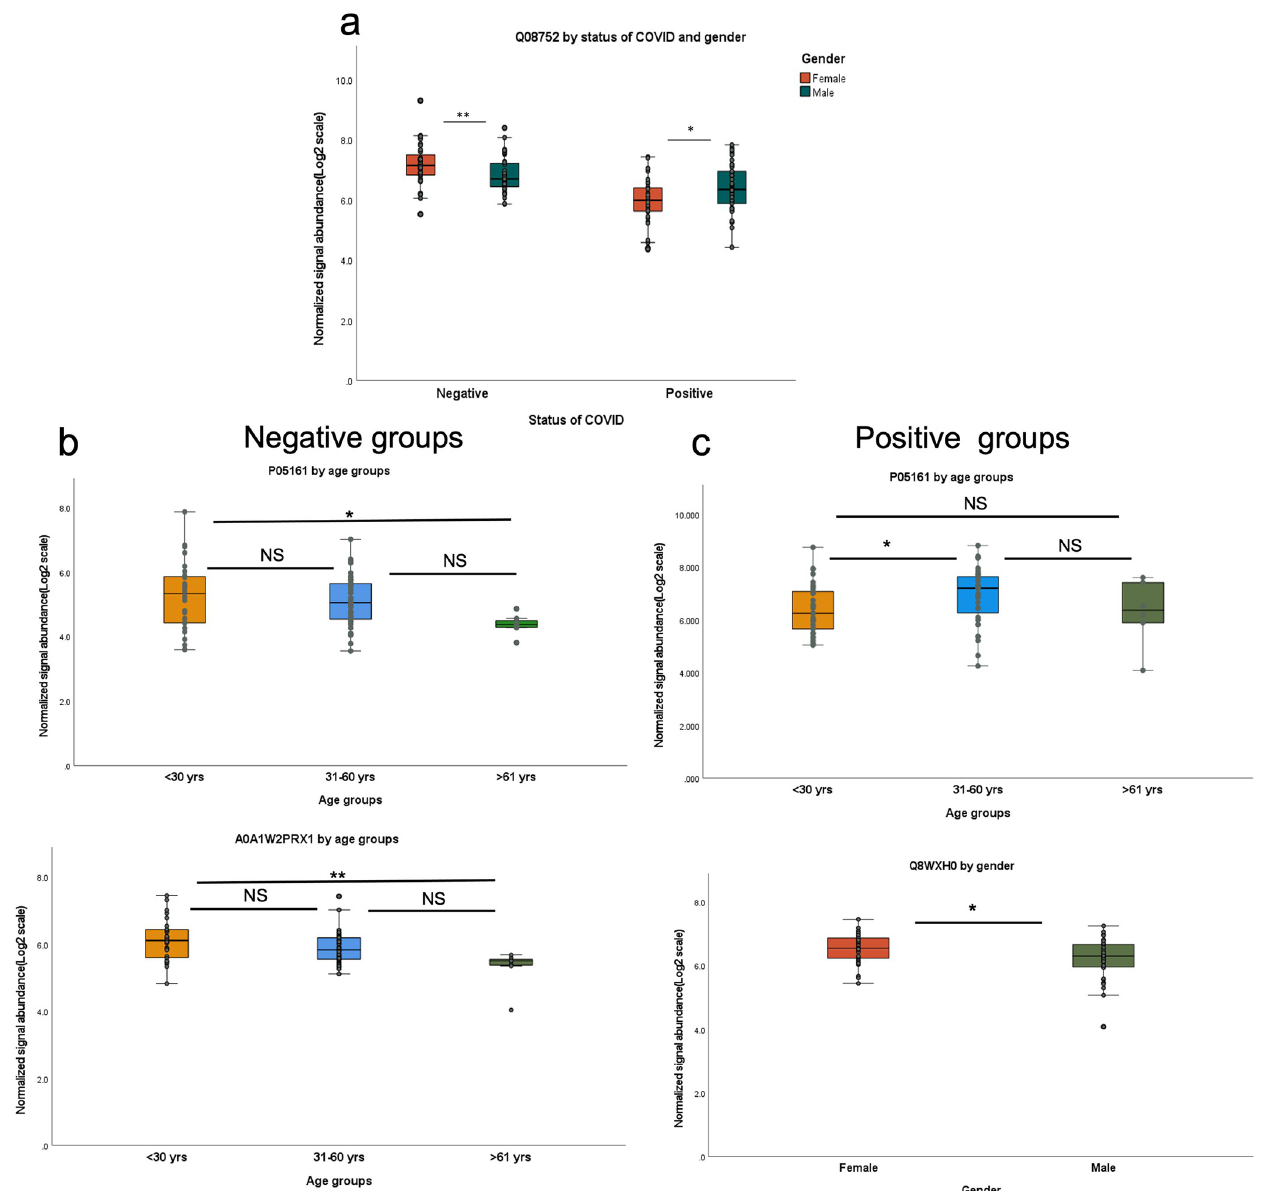
Fig 5. Box plots of proteomics by gender and age. a) Box plot represents significant difference of Q08752 (PPlase D) by gender in both SARS-CoV-2 negative groups( U = 467, p = 0.008) and positive groups( U = 504, p = 0.024). b) Box plot represents significant difference of proteins in the negative groups. The difference was indicated in P05161 (Ubiquitin-like protein ISG15)( χ 2 (2) = 6.029, p = 0.049) and A0A1W2PRX1 (HLA class I histocompatibility antigen) ( χ 2 (2) = 10.584, p = 0.005) by age groups. C) Box plot represents significant difference of proteins in the positive groups. The difference was indicated in P05161 by age groups ( χ 2 (2) = 5.998, p = 0.05) and Q8WXHO (nesprin-2) by gender ( U = 488, p = 0.015). The Mann-Whitney test was conducted to compare the difference of proteins between gender. Krustal-Wallis H test following Dunn’ s post-hoc test was conducted to compare the difference of proteins between age groups. � denotes p � 0.05 and �� denotes p <